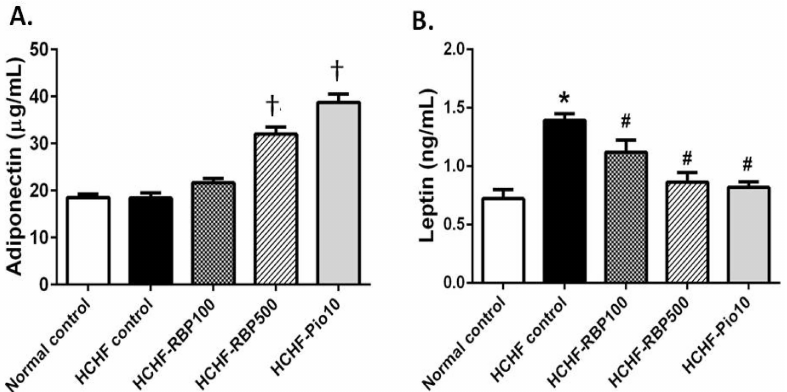
Figure 3. Effects of RBP on serum adeponectin ( A ) and leptin ( B ) in HCHF-fed rats. Oral administration of RBP 500 mg/kg or pioglitazone 10 mg/kg daily for 6 weeks significantly increased serum adiponectin relative to normal control, and decreased serum leptin relative to the HCHF control group. ( : : p < 0.05, significant increase as compared to HCHF-control group; * : p < 0.05, significant increase as compared to normal controls; # : p < 0.05, significant decrease as compared to HCHF-control